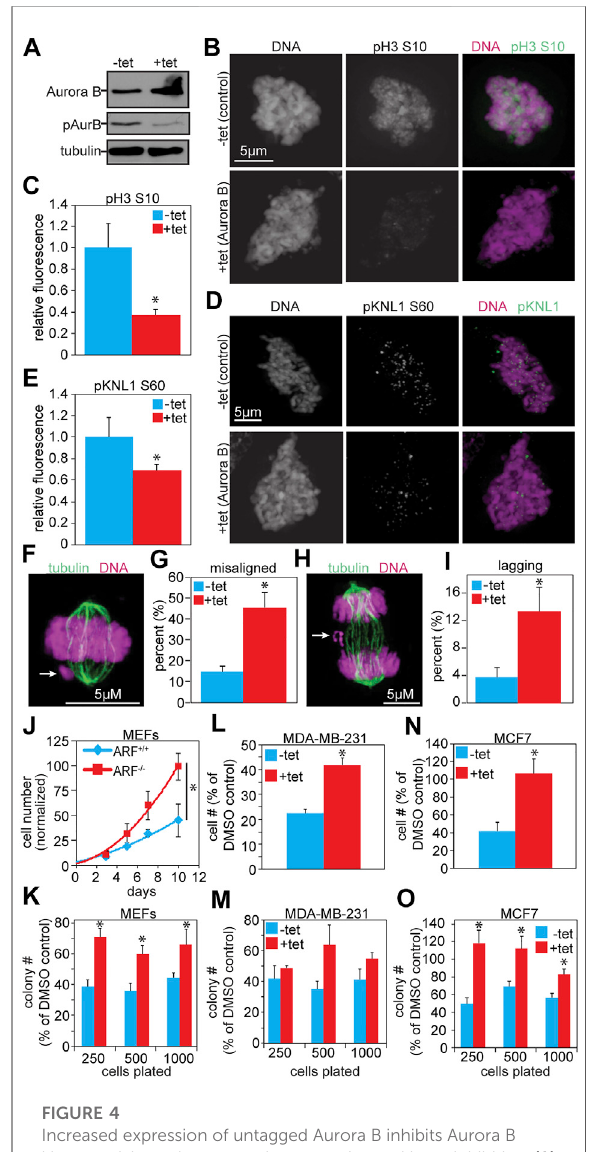
FIGURE 4 Increased expression of untagged Aurora B inhibits Aurora B kinaseactivityandcausesresistancetoAurorakinaseinhibition. (A) Immunoblot showing ≥ 2- fold overexpression of untagged Aurora B in MDA-MB-231 cells treated with tetracycline. Despite increased protein levels of Aurora B, pT232 (active) Aurora B is reduced. Tubulin is shown as a loading control. (B – E) Quantitative immuno fl uorescence showing that increased Aurora B expression results in reduced phosphorylation of the Aurora B substrates histone H3 and KNL1. (B,D) Representative images of pH3 and pKNL1 in MDA-MB-231 cells ± 48 h of tet-inducible expression of Aurora B (C,E) Quanti fi cation of B and D. n > 10 cells from each of 3 independent experiments. (F – I) 48 h of tet-induced Aurora B expression induces mitotic defects in MDA-MB-231 cells. (F) Representative image of a misaligned chromosome (arrow). (G) Elevated Aurora B expression increases the incidence of misalignedchromosomes. n > 50metaphasesfrom3independent experiments. (H) Representative image of a lagging chromosome (arrow). (I) Increased Aurora B expression induces lagging chromosomes. n > 100 anaphase and telophases from 3 independent experiments. (J – O) Increased Aurora B expression causes resistance to Aurora B inhibition. (J) Primary ARF − / − MEFs ( Continued expressing elevated levels of untagged Aurora B in response to